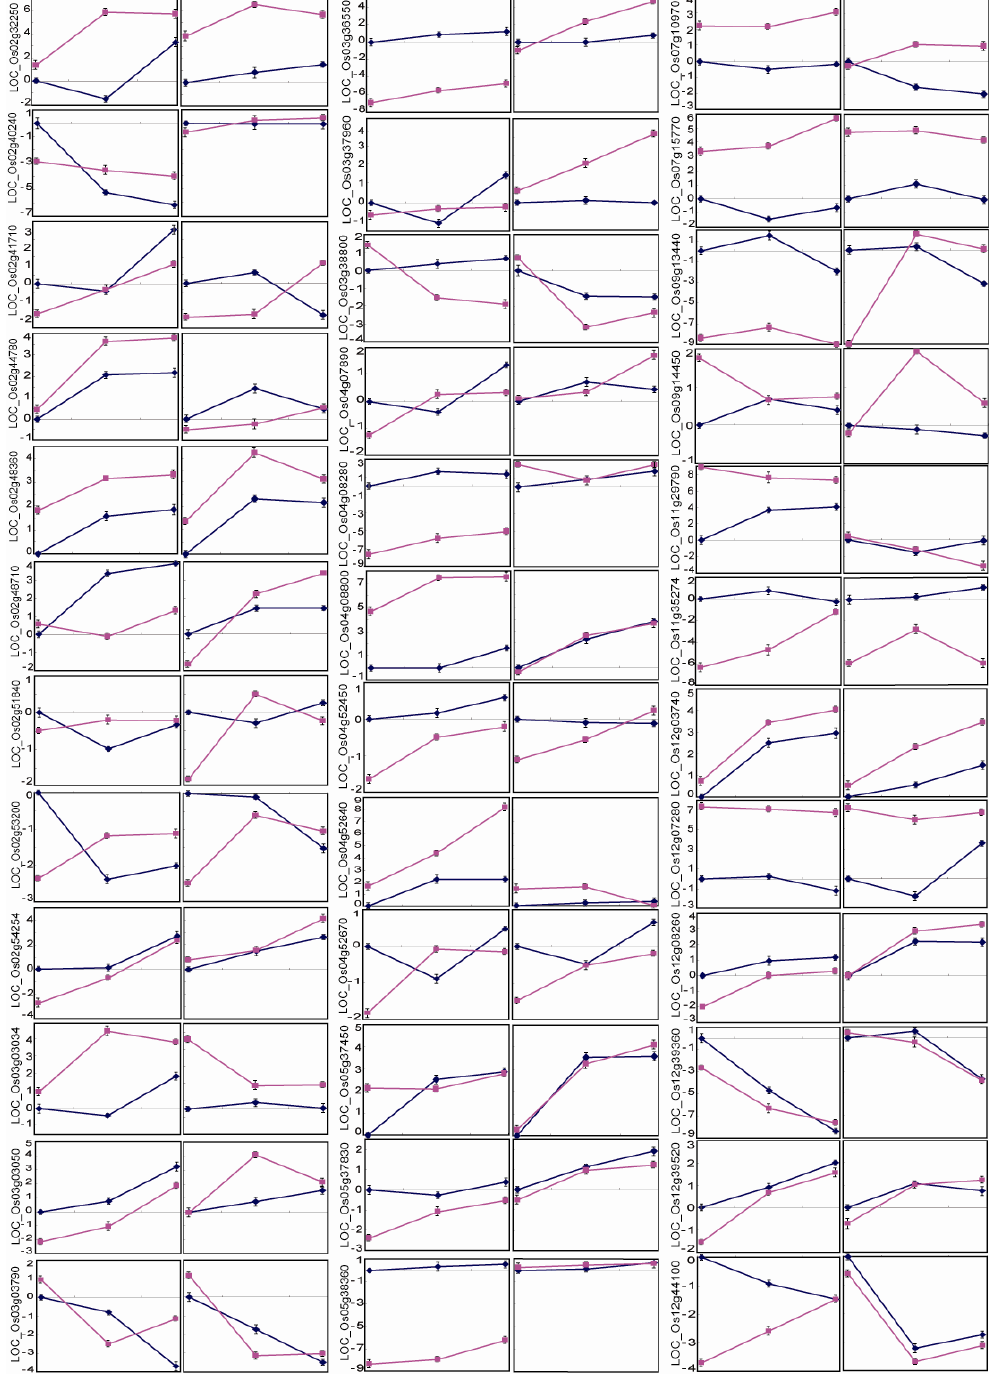
Figure 4. Real-time PCR analysis for 36 genes in ZS97, IRAT109, NIL-ZS and NIL-IR. The left figure for each gene illustrates its expression profile in ZS97 and IRAT109; right figure illustrates its expression profile in NIL-ZS and NIL-IR. The colored lines denote the expression profile of the 36 drought-responsive genes: blue indicates allele from ZS97 and red indicates allele from IRAT109. The x-axes are three time points of drought stress treatment, and the y-axes are scales of transcription ratios determined from the real-time PCR were ln-transformed. D0, before drought stress; D1 and D2, two stages of drought